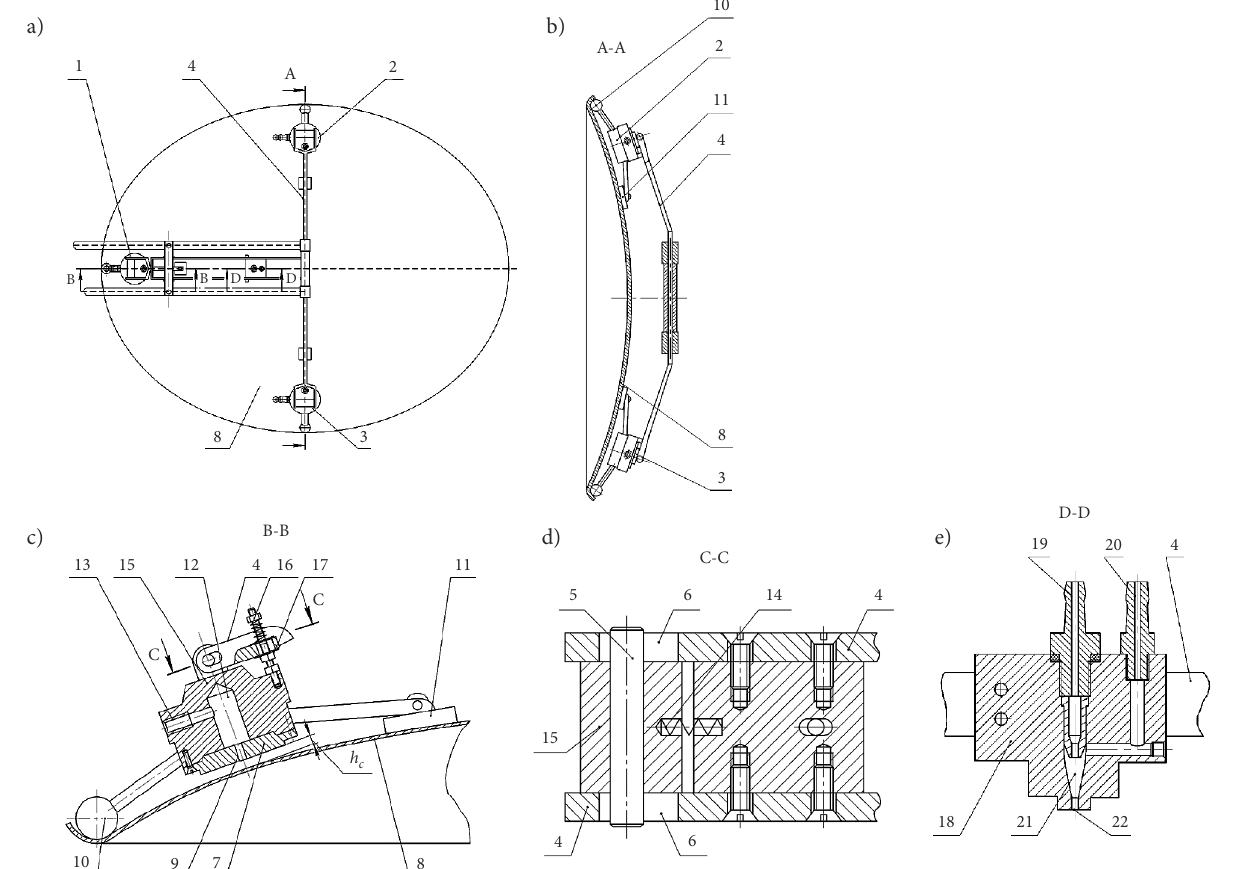
Figure 1. Design and cross-sections of individual mechanisms of the device for gripping and controlling the shape of plates of offset mirror